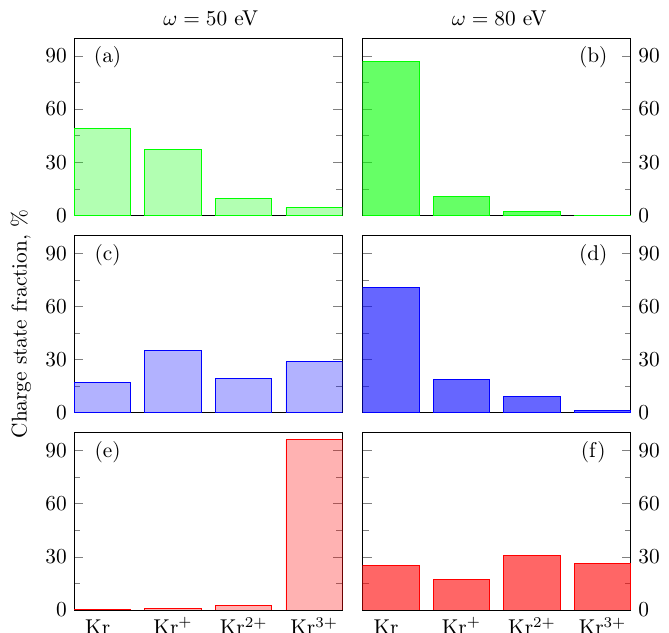
Figure 3. Charge-state yields for three fluences: F = 40 ph/Å 2 ( a , b ), F = 100 ph/Å 2 ( c , d ), and F = 400 ph/Å 2 ( e , f ) for the photon energies 50 eV ( a , c , e ) and 80 eV ( b , d , f